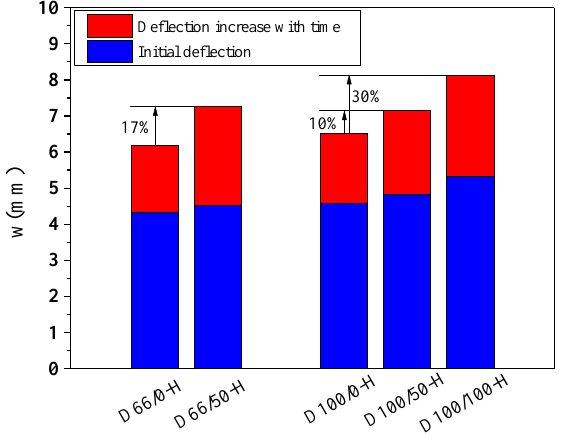
ff ect of the RFAs on the ultimate Figure 12. Effect of the RFAs on the ultimate deflection. Figure 12. E Figure 12. Effect of the RFAs on the ultimate deflection.